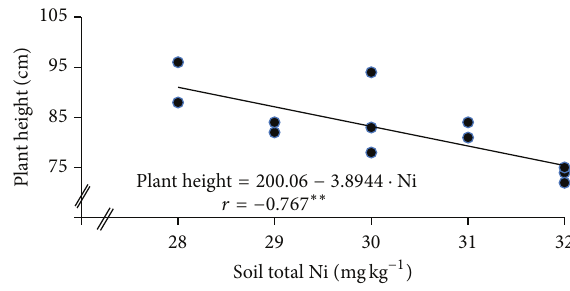
Figure 1: Relationship between organic matter and available B content of soil in the 2003 experiment ( ∗∗ 𝑝 < 0.01 ).